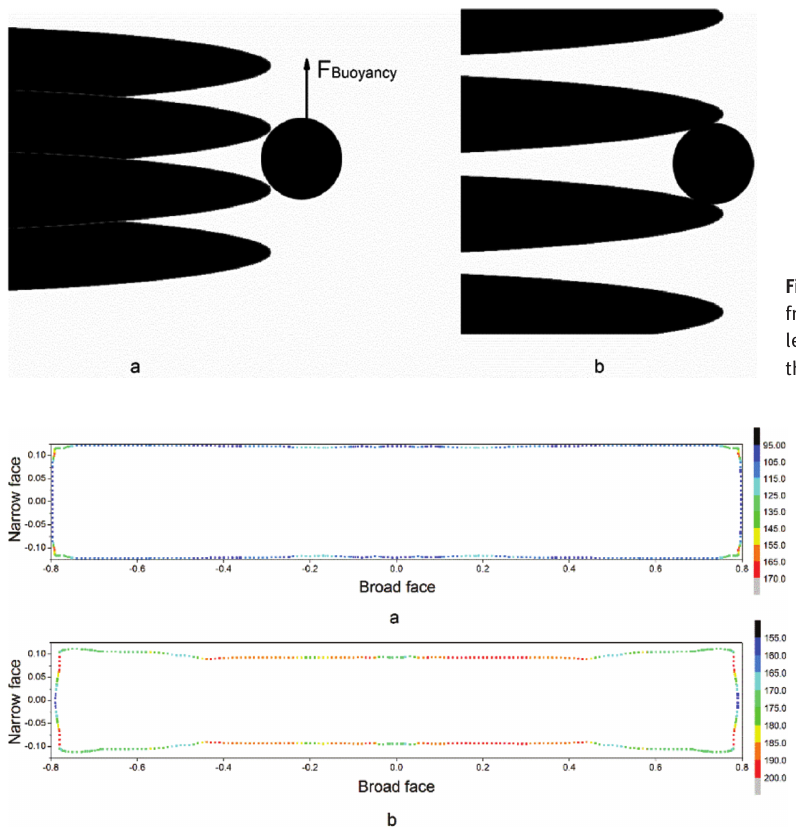
Figure 8: PDAS of solidification front at different mold cross sections: 0.2m (a) and 1m (b) from the meniscus.